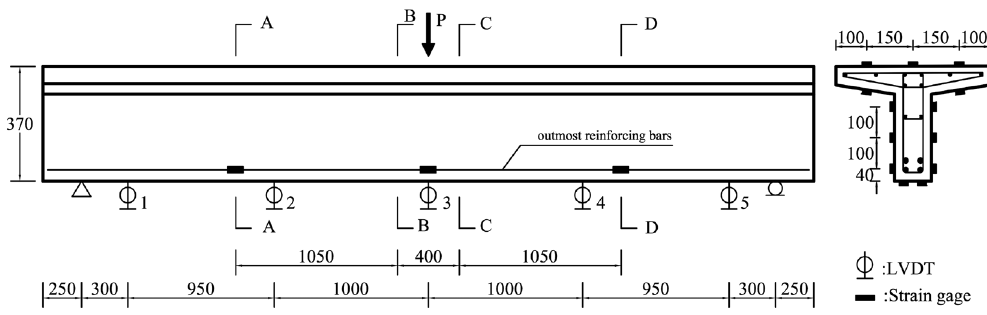
Figure 2. Test setup and instrumentation (unit: